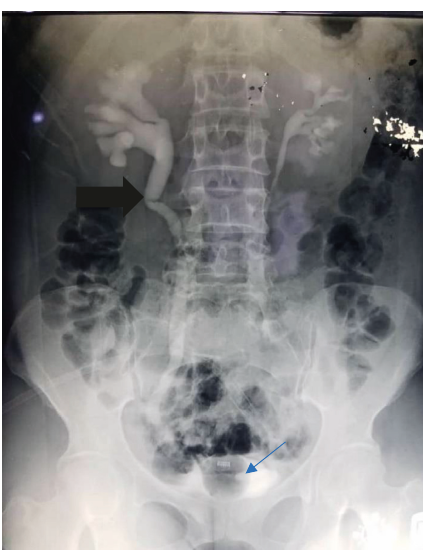
Figure 1: Intravenous urogram showing grade II right hydro- nephrosis with hydroureter (large arrow) and left ureterocele (small